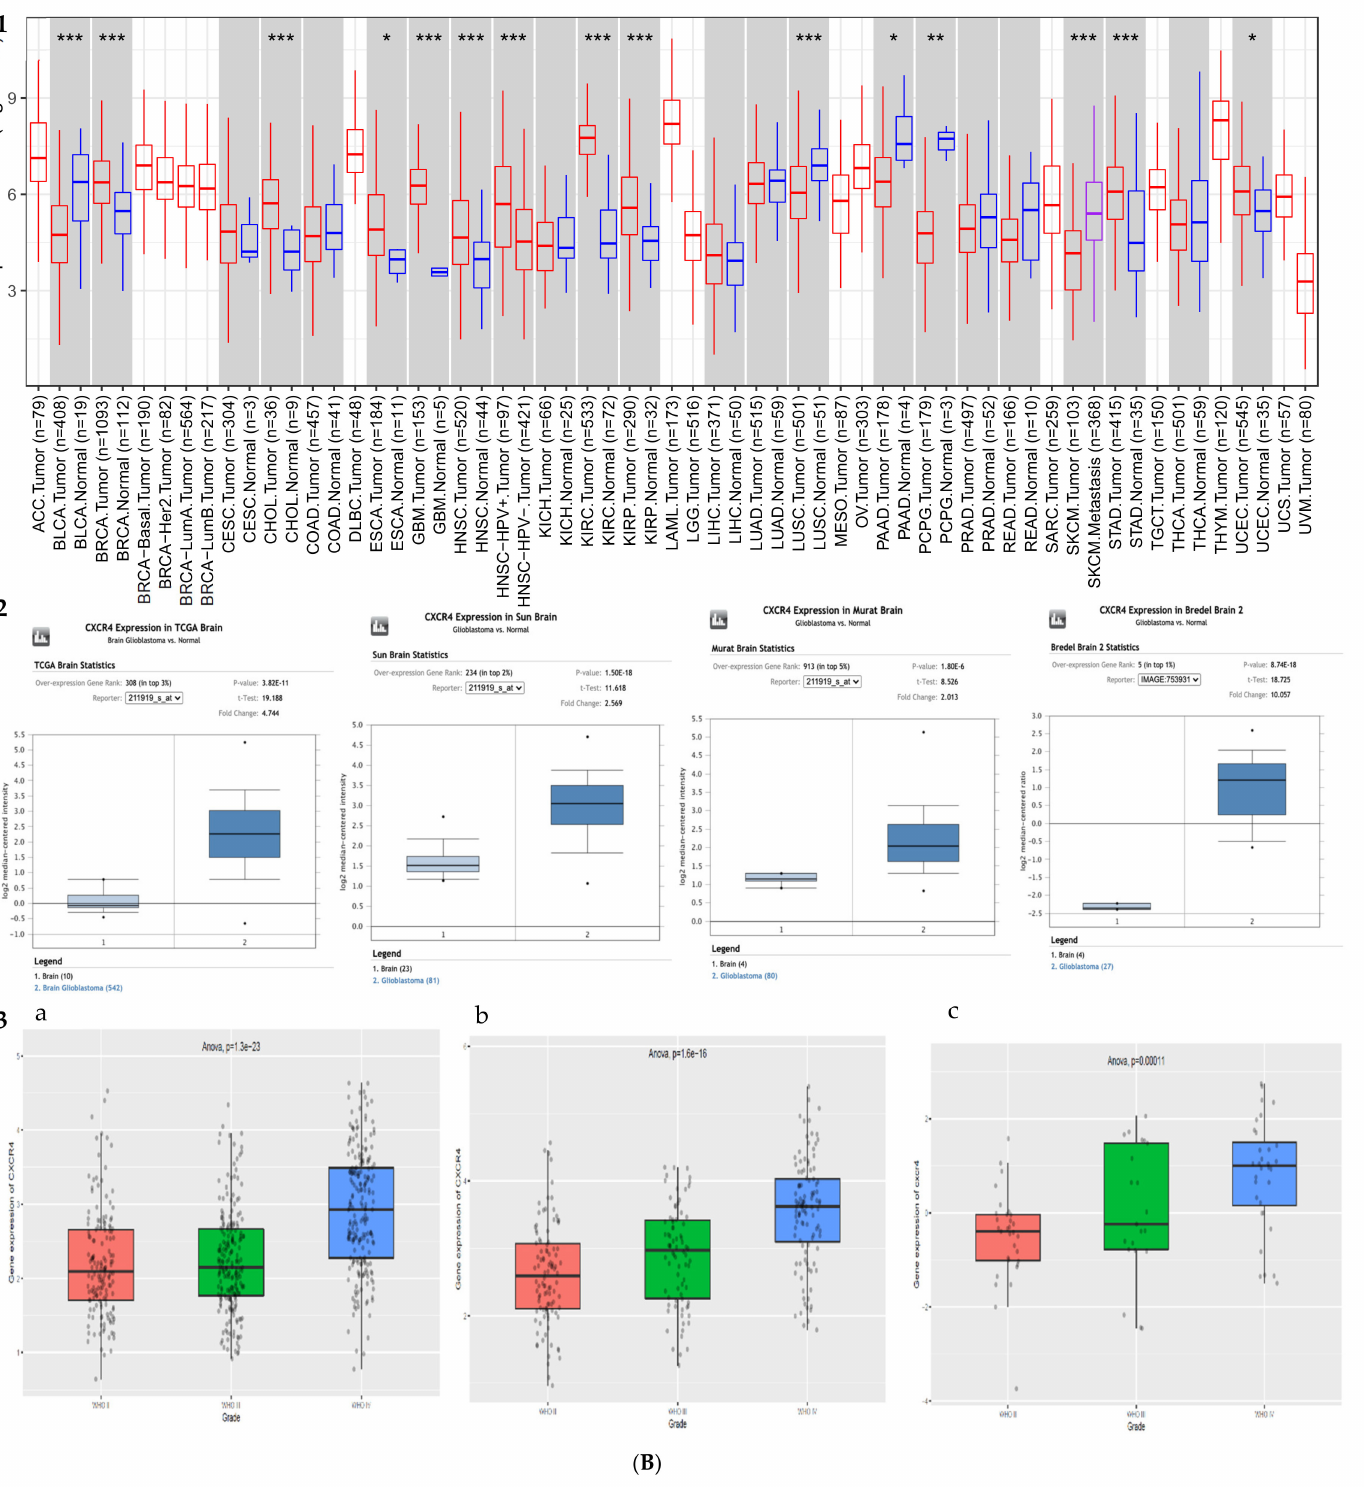
Figure 1. ( A ): Differential expression profiles of BIRC5. ( A1 ) Across all cancer vs. corresponding normal tissue samples in TCGA data base using timer. ( A2 ) Oncomine database across 4 different studies of GBM ( A3 ) between WHO grade II, III, and IV Glioma samples from CGGA database (a) mRNAseq n = 693, (b) mRNAseq n = 325, and (c) mRNA-array n = 301. ( B ): Differential expression profiles of CXCR4. ( B1 ) Across all tumour vs. corresponding normal tissue samples in TCGA data base using timer. ( B2 ) Oncomine database across 4 different studies of GBM ( B3 ) between WHO grade II, III, and IV Glioma samples from CGGA database (a) mRNAseq n = 693, (b) mRNAseq n = 325, and (c) mRNA-array n = 301. (*: p -value < 0.05; **: p -value < 0.01; ***: p -value <